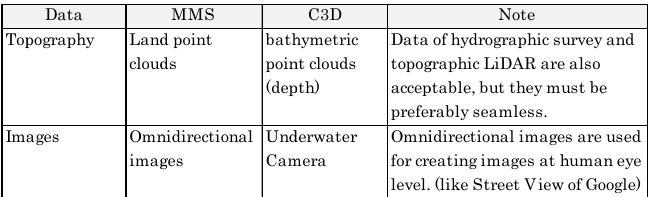
for Sensor Georeferencing Mapping for Damage survey after Great east Japan earthquake